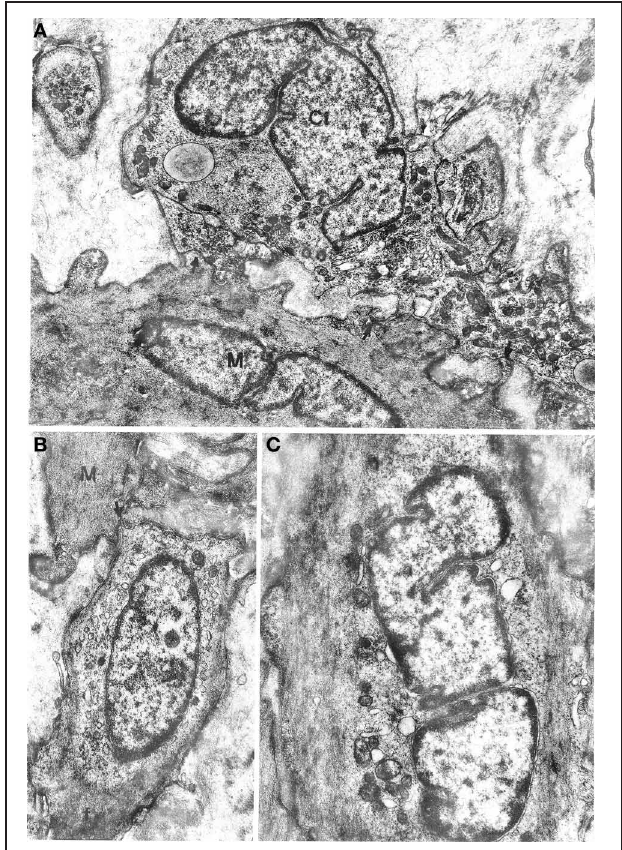
FIGURE 3 | (A) Oesophageal muscle coat. Ci: interstitial cell rich in mitochondria and smooth endoplasmic reticulum and with a well-developed Golgi apparatus at a nuclear pole. Arrows point to close contacts with neighboring interstitial cells and with a muscle cell (M). A basal lamina surrounds the cell almost entirely. × 9400. (B,C) Gastric muscle coat. An interstitial cell with thin filaments (f) at the cell periphery is shown in (B) . The arrow points to a close contact with a muscle cell (M). × 11,400. An interstitial cell with few organelles near the nucleus and many filaments parallel to the cell major axis is shown in (C) . Many pinocytotic vesicles are located along the plasma membrane. ×